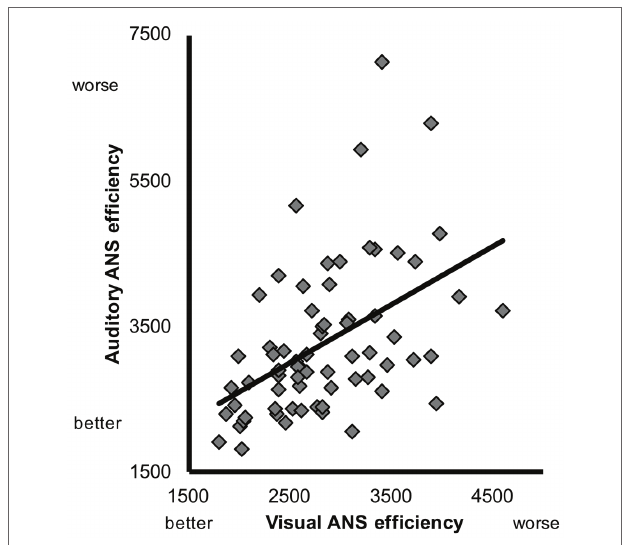
FIGURE 2 | Scatterplot depicting the relation between visual and auditory ANS efficiency prior to training.